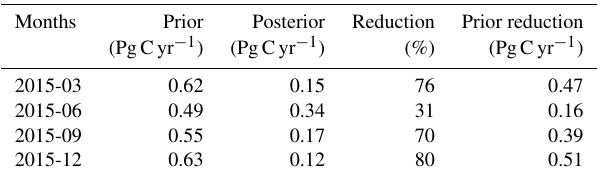
Figure 6. Aggregation of land cover classes over CMAQ domain using MODIS Land Cover Type Product (MCD12C1) Version 6 data product. Colour bars represent each category: (0) ocean, (1) grasses and cereal, (2) shrubs, (3) evergreen needleleaf forest, (4) savannah, (5) evergreen broadleaf forest, and (6) unvegetated land. Table 4. Prior and posterior uncertainties (in PgCyr − 1 ) for an en- semble of five realizations aggregated over the Australian continent. Date format is